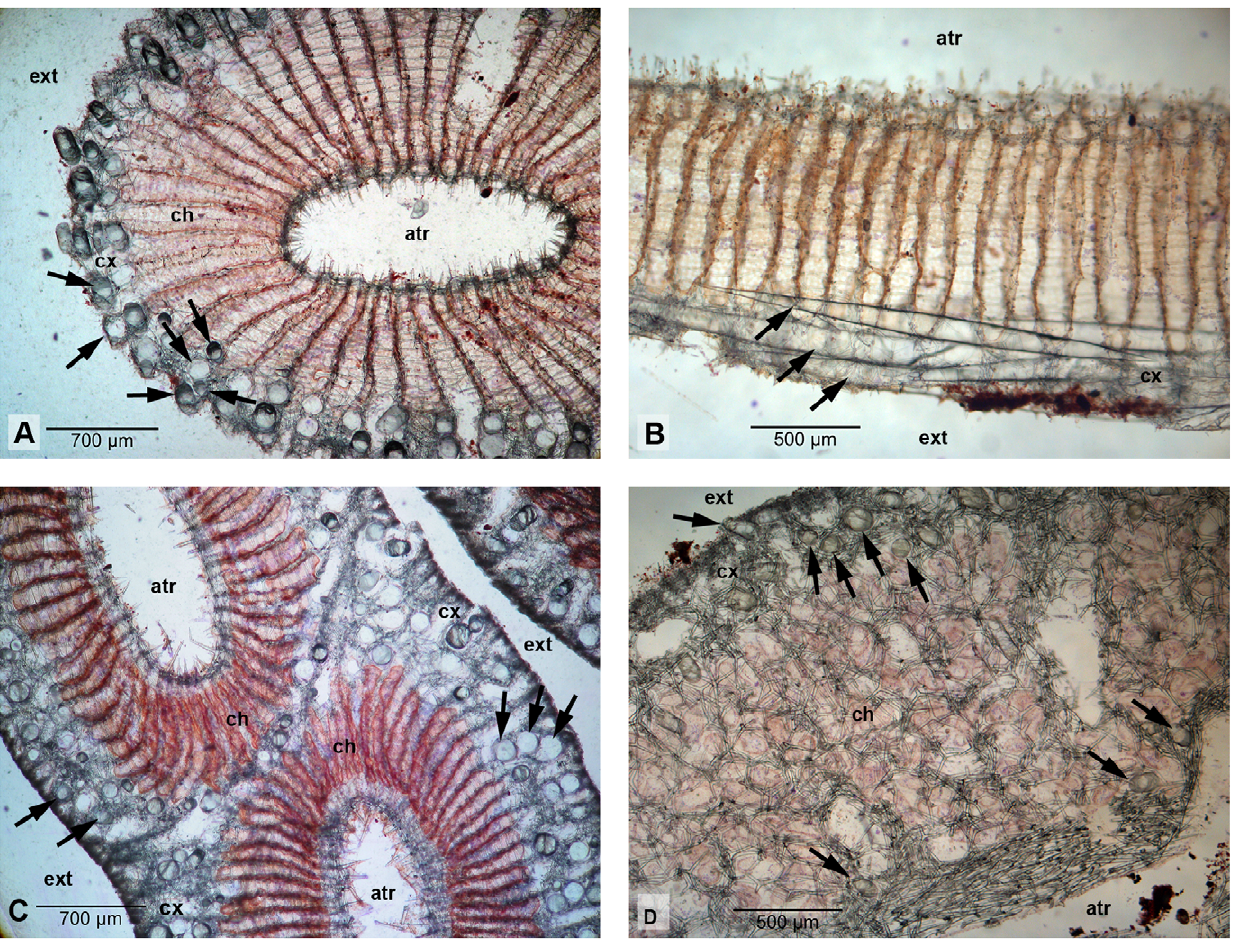
Figure 4. Skeletal organization of Grantiidae of clade LEUC I. A,B: Ute aff. syconoides (GW975) in cross section (A) and longitudinal section (B); C: Cross section of Synute pulchella ; D: Cross section of Aphroceras sp. Arrows point to the giant longitudinal diactines. atr=atrium; ch=choanosome; cx=cortex, ext=exterior of the sponge.